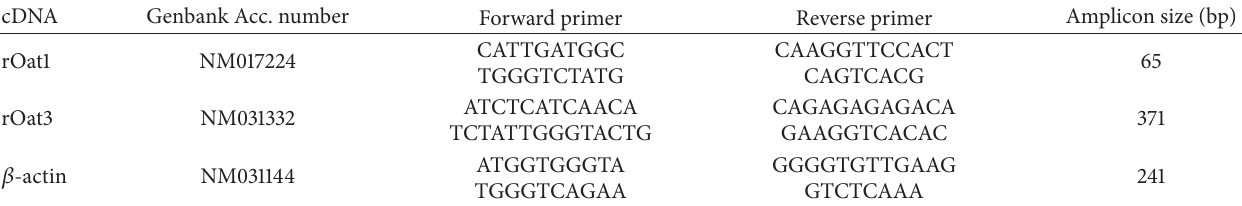
Table 1: Primer sequences and expected amplicon sizes for the gene